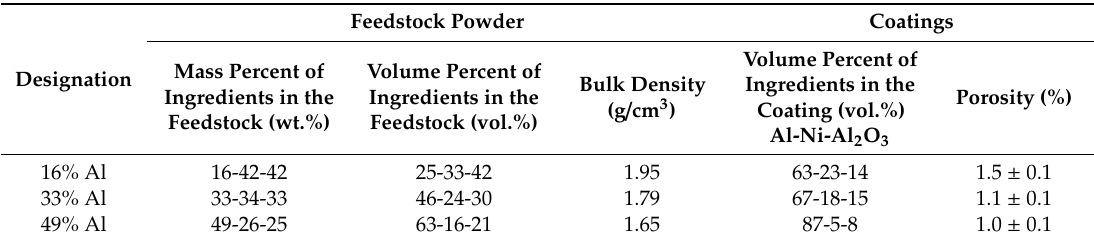
Figure 3. As-sprayed coatings (SEM, BSE) of Al+Ni+Al 2 O 3 with 16 wt.% of Al ( a ), 33 wt.% of Al ( b ), 49 wt.% of Al ( c ). Table 3. Composition of feedstock powders and corresponding coatings. Table 3. Composition of feedstock powders and corresponding coatings.